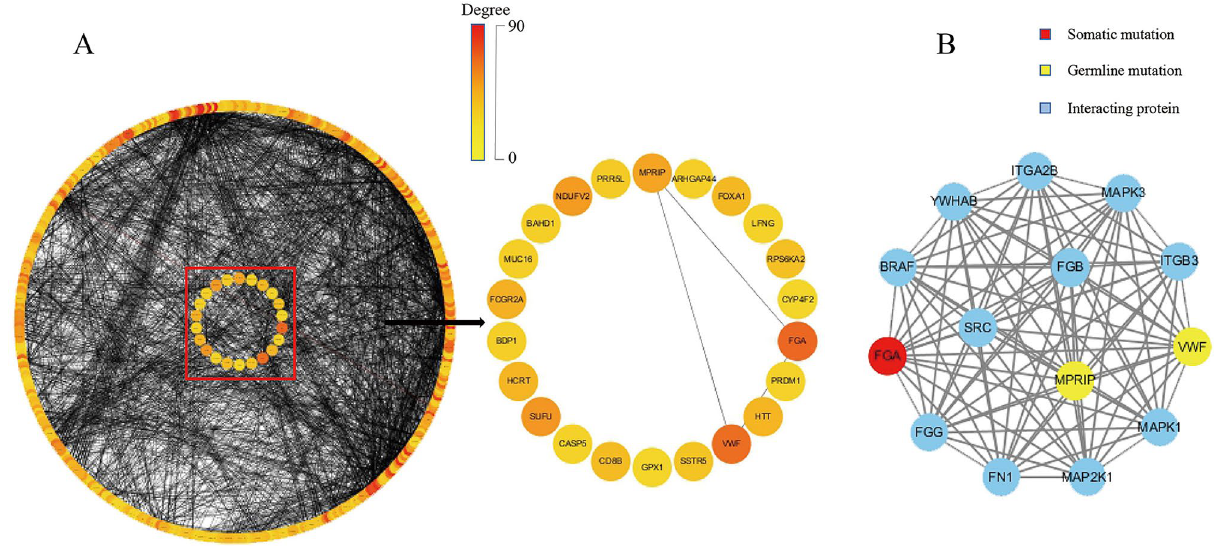
Figure 2. PPI network and functional modules. ( A ) PPI network. left: 436 nodes and 2888 edges. The outer circle represents interaction proteins whereas the inner circle represents candidate genes. right: Among 22 candidate genes, FGA and VWF have the highest Degree, and interact with MPRIP. The color indicates a change in Degree. The darker color indicates greater Degree and more important function node in the network ( B ) VWF , MPRIP and FGA belong to the same function module. yellow, red and blue represents germline mutation, somatic mutation, and interaction protein,